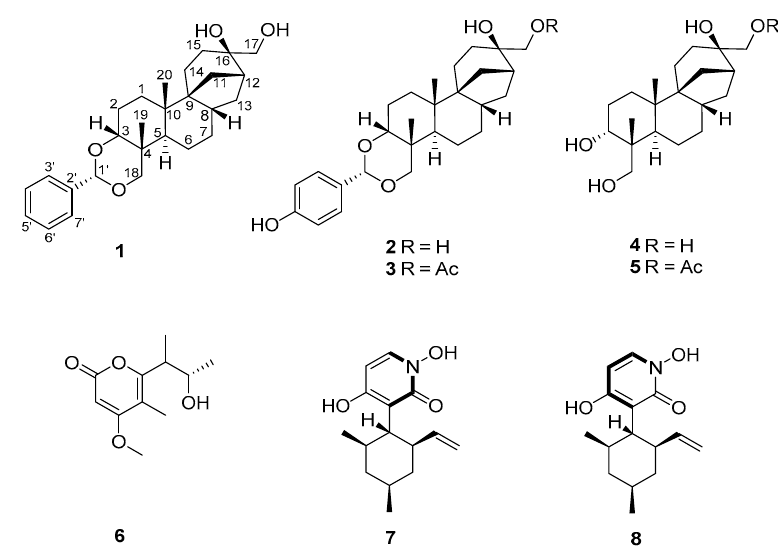
Figure 1. Structures of compounds 1 – 8 .